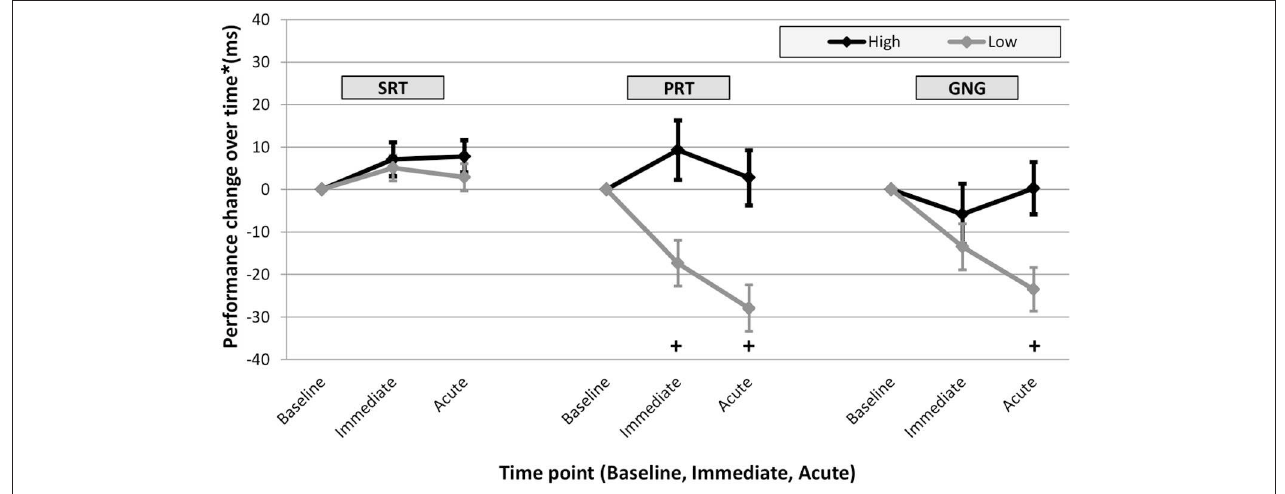
FIGURE 1 | Adjusted* change score means (and standard error bars) for Immediate and Acute performance by DANA subtest. Change score are plotted over time for participants exposed to > 5 psi peak overpressure (“High,” black), and participants exposed to 5 psi or less peak overpressure (“Low,” gray). In both PRT and GNG, the “High” exposure group mean performance change was statistically different from the “Low” group; participants with higher peak overpressure exposure have a reduced level of improvement. Further analyses (regression) resulted in statistically significant differences between “High” and “Low” groups in PRT at the Immediate and Acute time point in PRT and at the Acute time point in GNG as indicated below by “ + . ” *Mean values estimated from regression using “High” and “Low” peak overpressure exposure